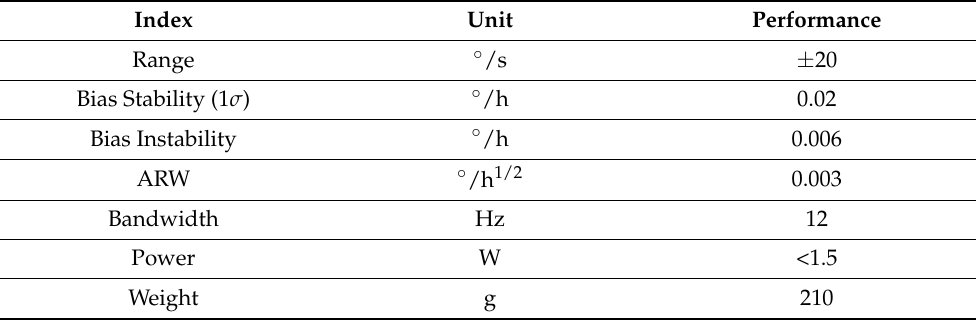
Table 3. The IMU performance